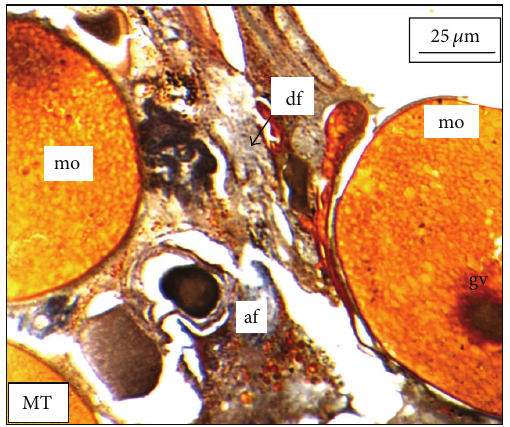
Figure 6: The histological section of the ovary of a M. tengara during the early spawning phase (June) showing maturing follicles (mf) with impeded yolk deposition. Empty yolk vesicles (solid white arrows) around the basophilic germinal vesicle (gv) under experimental condition when the tissues are treated with ZnS nanoparticles at the concentration of 250 𝜇 g/L also support the deposition of the yolk material centripetally [Mallory’s triple stain].